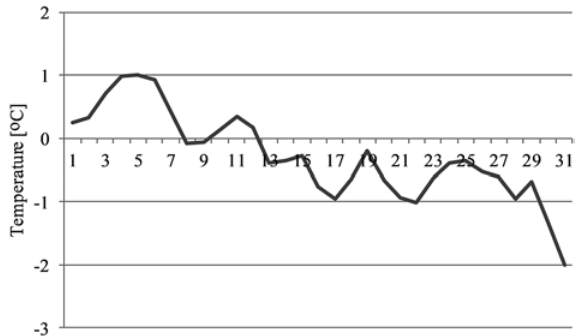
Fig. 3. Mean daily air temperature (°c) in december between 1966 and 2014 in Poland.